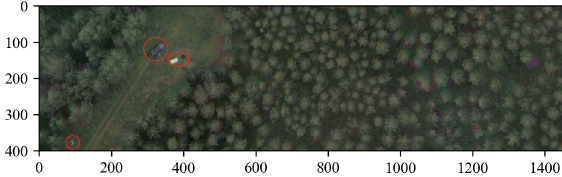
Figure 5. Test dataset for the anomaly detection from the forest. Inside of red circulated areas are anomalous objects (three reflectance panels, one black panel, one blue van, and cross-shaped georeferencing signal).